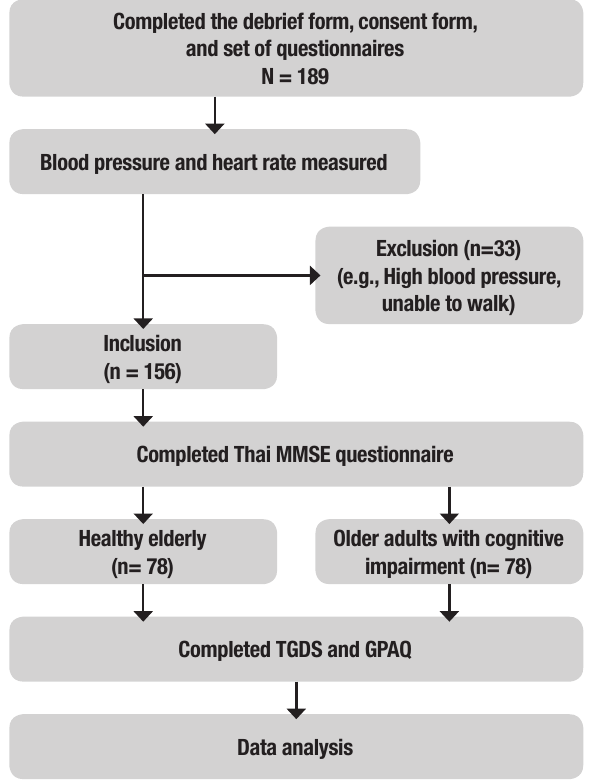
Figure 1. Summary diagram depicting stages of the study.